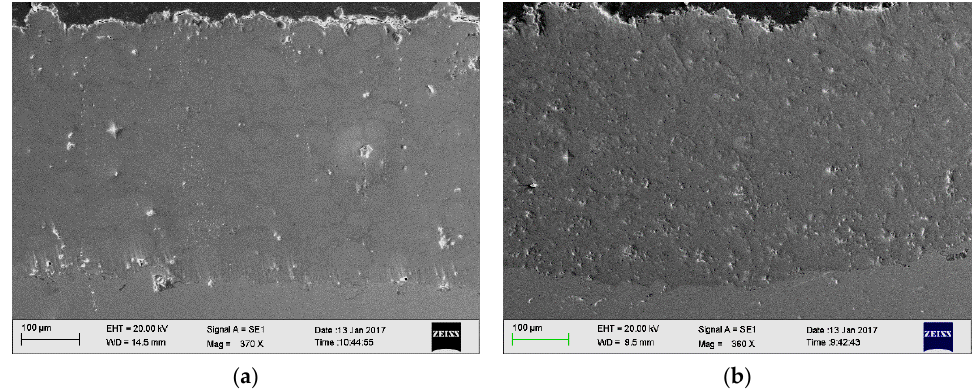
Figure 3. SEM images of the polished cross sections for ( a ) the shrouded plasma-sprayed Ti coating and ( b ) atmospheric plasma-sprayed Ti coating.